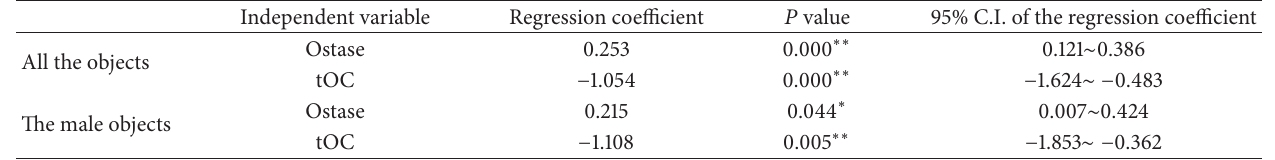
Table 5: Stepwise multiple regression analysis showing variables independently associated with HbA1c.